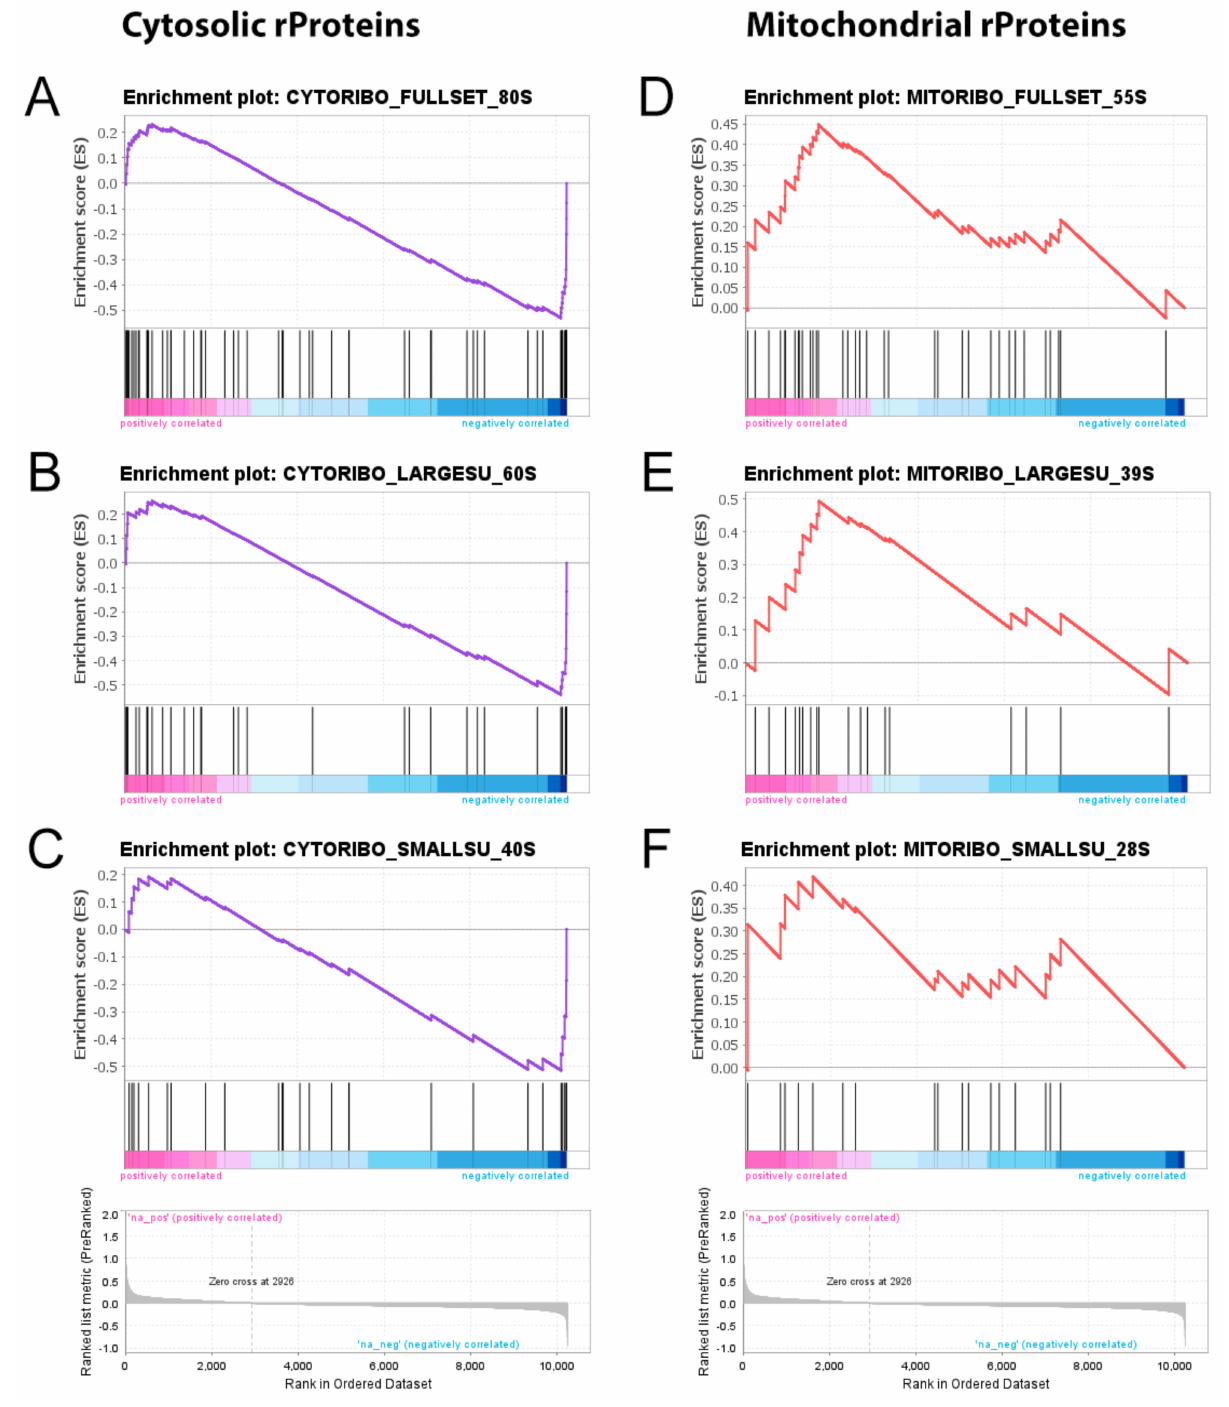
Figure 4. Gene set enrichment analysis of the ribosomal protein gene set . (( A )–( C )) Downregulated cytosolic rProtein transcripts were significantly enriched ( q -values: 1.5 · 10 − 4 , 0.002, and 0.013 for the 80S, 60S, and 40S subunit gene sets, respectively). (( D )–( F )) In contrast, the mitochondrial rProtein genes showed a consistent upregulation ( q -values: 0.205, 0.151, and 0.231 for the 55S, 39S, and 28S subunit gene sets,